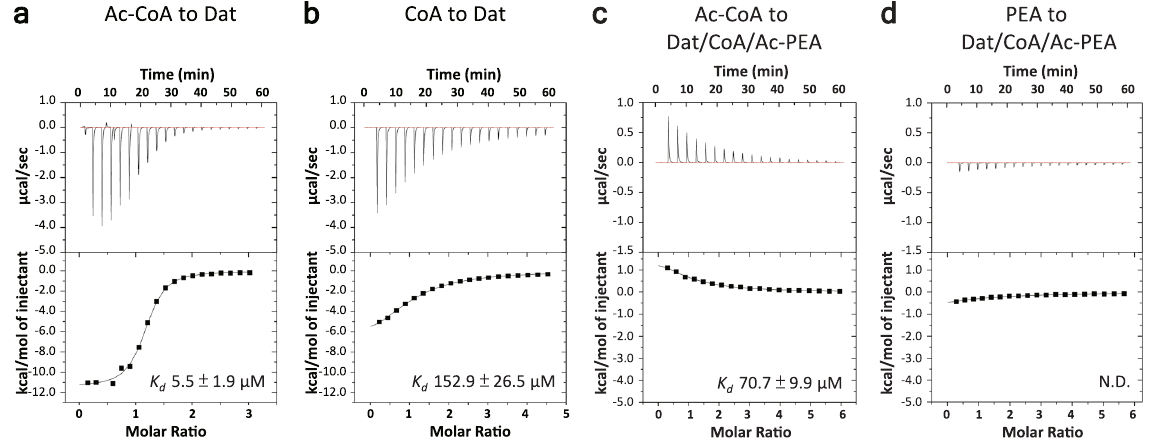
Fig. 5 Investigation of Dat catalytic cycle by ITC experiment. a , b ITC-binding study on Ac-CoA to apo-Dat ( a ), and CoA to apo-Dat ( b ). c , d ITC-titration experiment of Ac-CoA against the Dat/CoA/Ac-PEA ternary complex ( c ), and PEA against the Dat/CoA/Ac-PEA ternary complex ( d ). K d values were calculated with n = 6 biologically independent experiments. N.D. data cannot be determined. Table 2 ITC analysis of acetyl-CoA, CoA, PEA, and Ac-PEA binding against Dat. Group